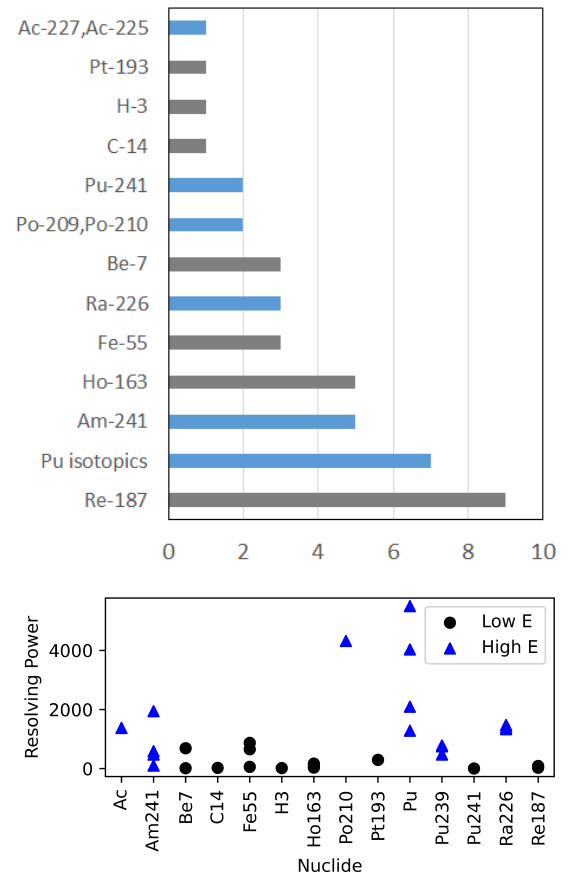
Figure 4. ( Top ) Nuclides measured with DES detectors. The bars in grey represent the low energy nuclides that decay primarily by electron capture or beta decay. The bars in blue represent the high energy nuclides that decay primarily by α decay. ( Bottom ) As a function of nuclide, the resolving power does not appear to show any discernible